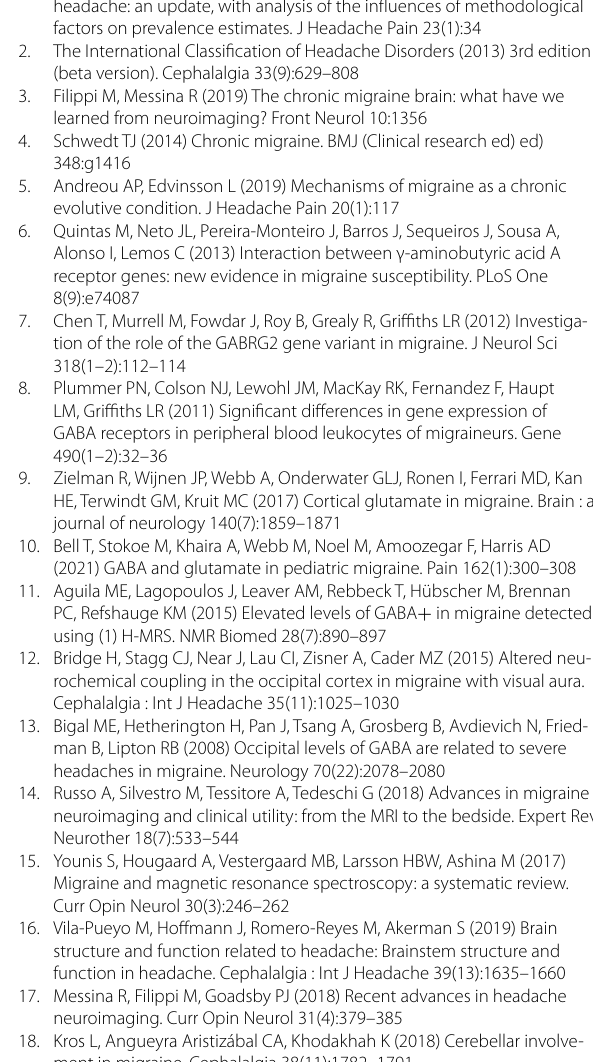
coefficient (r). Gray shading represents the 95% confidence intervals of the partial correlations. Patient Health Questionnaire-9; PAG, periaque- ductal gray; DN, dentate nucleus; GABA, gamma-aminobutyric acid; Glx, glutamate/glutamine. Fig. S6. Associations between the GAD-7 score and neurochemical levels. (A) and (B) show the correlation between the GAD-7 score and GABA level in the PAG. (C) and (D) show the correlation between the GAD-7 score and Glx level in the PAG. (E) and (F) show the correlation between the GAD-7 score and GABA level in the DN. (G) and (H) show the correlation between the GAD-7 score and Glx level in the DN. Dots represent participants with migraine. The black regression line represents Pearson’s correlation coefficient (r). Gray shading represents the 95% confidence intervals of the partial correlations. Generalized Anxi- ety Disorder-7; PAG, periaqueductal gray; DN, dentate nucleus; GABA, gamma-aminobutyric acid; Glx, glutamate/glutamine. Fig. S7. Associa- tions between the PSQI score and neurochemical levels. (A) and (B) show the correlation between the PSQI score and GABA level in the PAG. (C) and (D) show the correlation between the PSQI score and Glx level in the PAG. (E) and (F) show the correlation between the PSQI score and GABA level in the DN. (G) and (H) show the correlation between the PSQI score and Glx level in the DN. Dots represent participants with migraine. The black regression line represents Pearson’s correlation coefficient (r). Gray shading represents the 95% confidence intervals of the partial correlations. PSQI, Pittsburgh Sleep Quality Index; PAG, periaqueductal gray; DN, dentate nucleus; GABA, gamma-aminobutyric acid; Glx, glutamate/glutamine. Fig. S8. Associations between the MoCA score and neurochemical levels. (A) and (B) show the correlation between the MoCA score and GABA level in the PAG. (C) and (D) show the correlation between the MoCA score and Glx level in the PAG. (E) and (F) show the correlation between the MoCA score and GABA level in the DN. (G) and (H) show the correlation between the MoCA score and Glx level in the DN. Dots represent participants with migraine. The black regression line represents Pearson’s correlation coefficient (r). Gray shading represents the 95% confidence intervals of the partial correlations. MoCA, Montreal Cognitive Assessment; PAG, periaqueductal gray; DN, dentate nucleus; GABA, gamma-aminobutyric acid; Glx, glutamate/glutamine